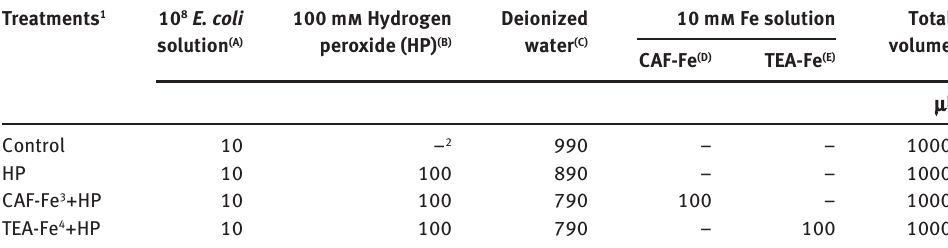
Table 2 Volume of each reagent used in the disinfection treatments. Treatments 1